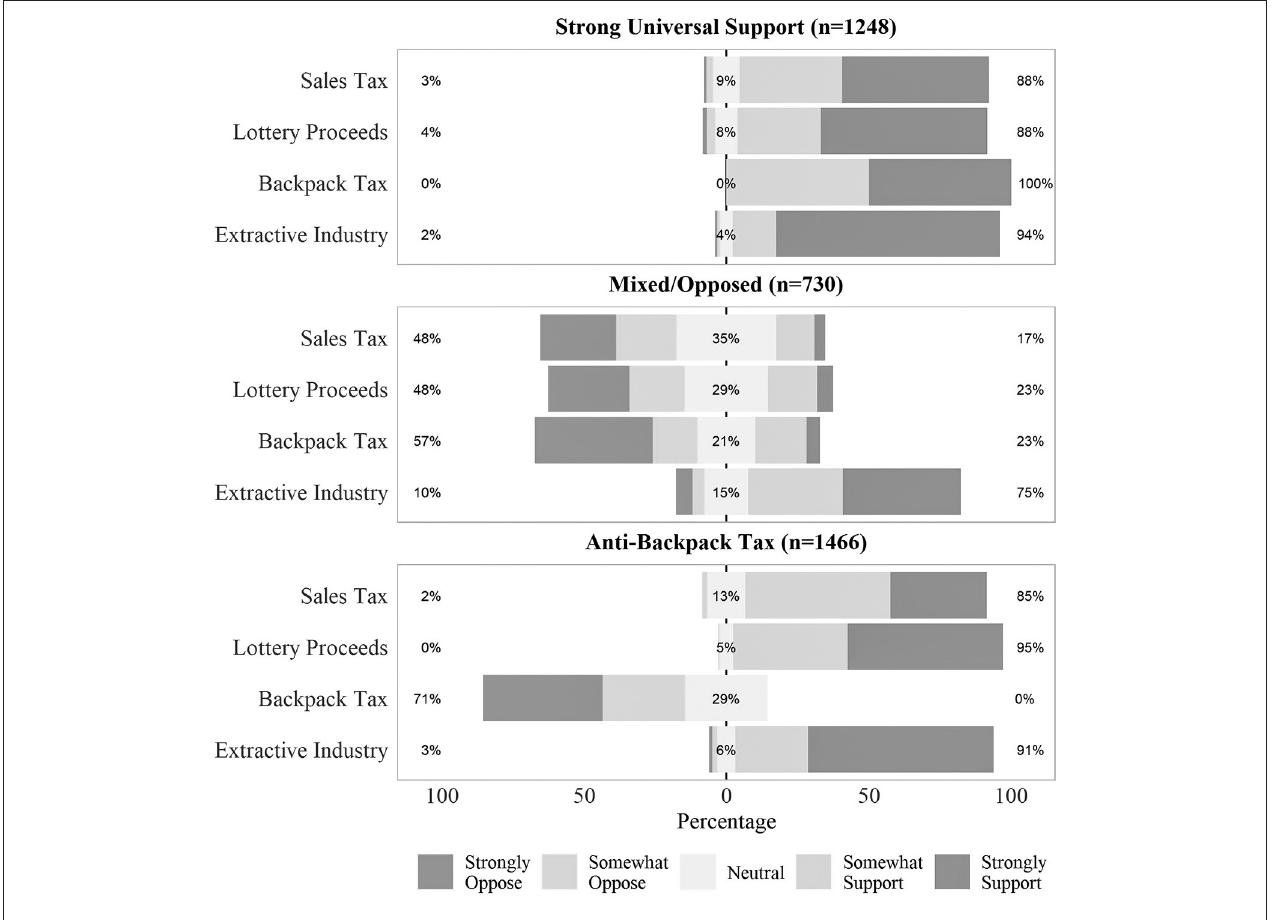
FIGURE 2 | Conservation funding policy support by cluster